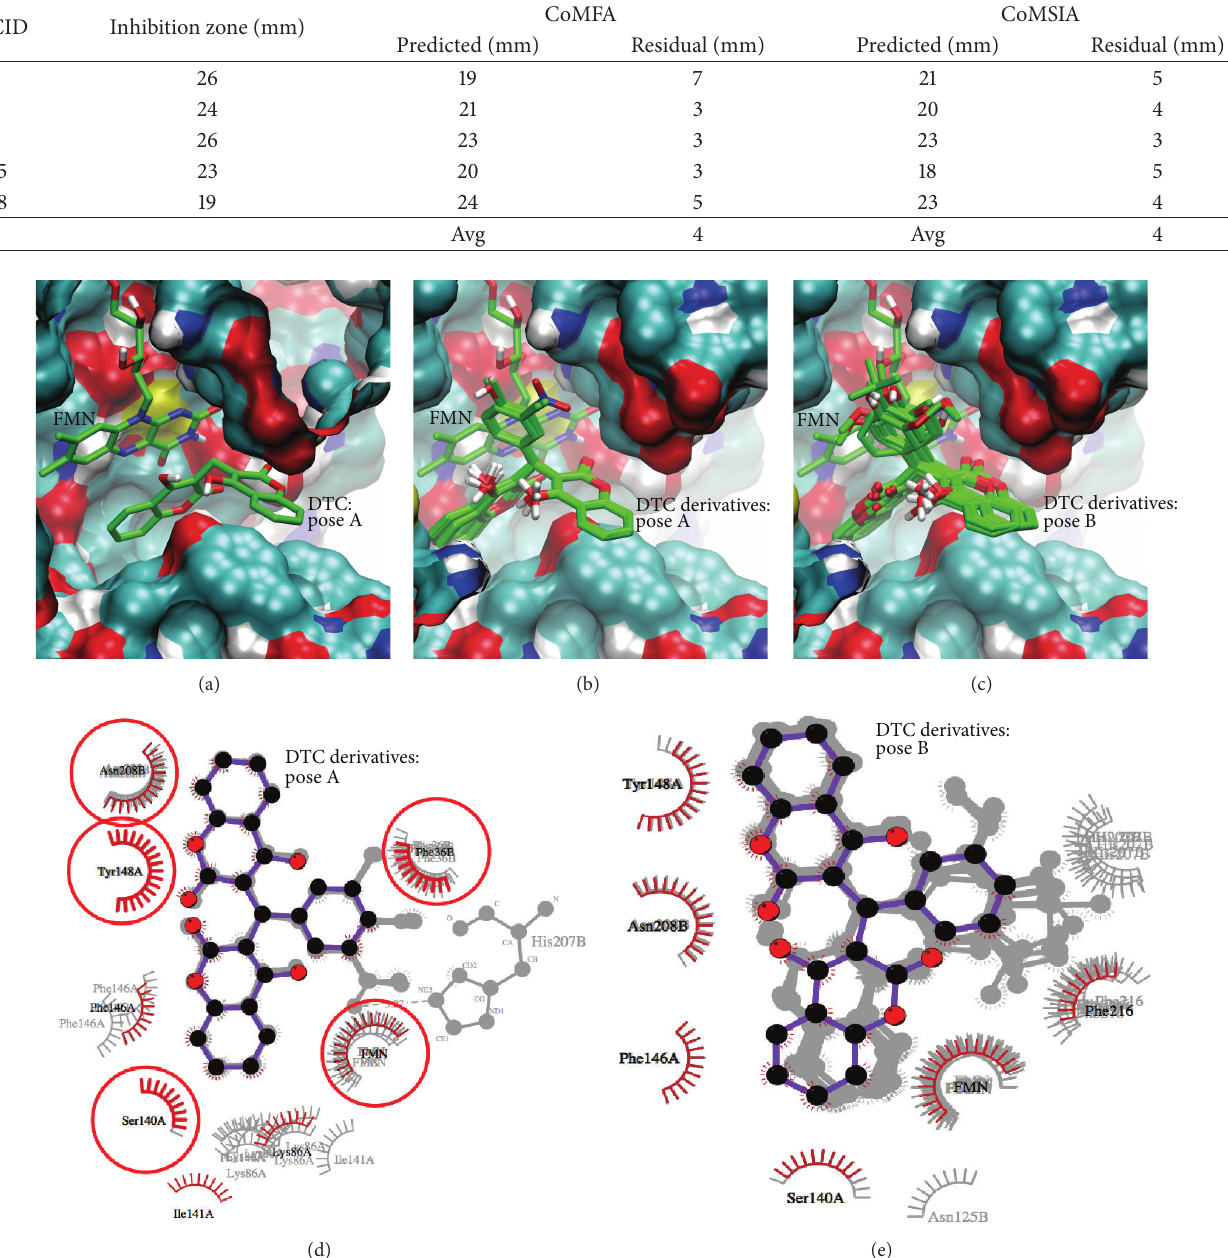
Figure 5: Docked orientations and interactions of dicoumarol derivatives in the enzyme binding site. (b) and (c) are the docking poses A and B of compound derivatives in comparison with pose A of dicoumarol (a) in the pocket (surface representation). (c) and (d) are schematic 2D diagrams of protein-ligand binding poses A and B,